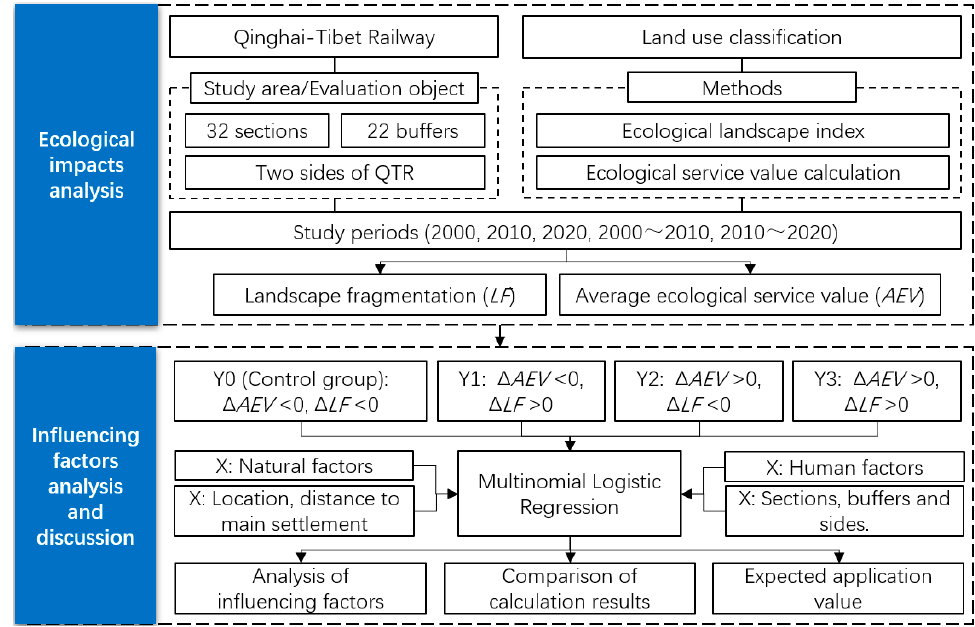
Figure 2. Analysis framework.